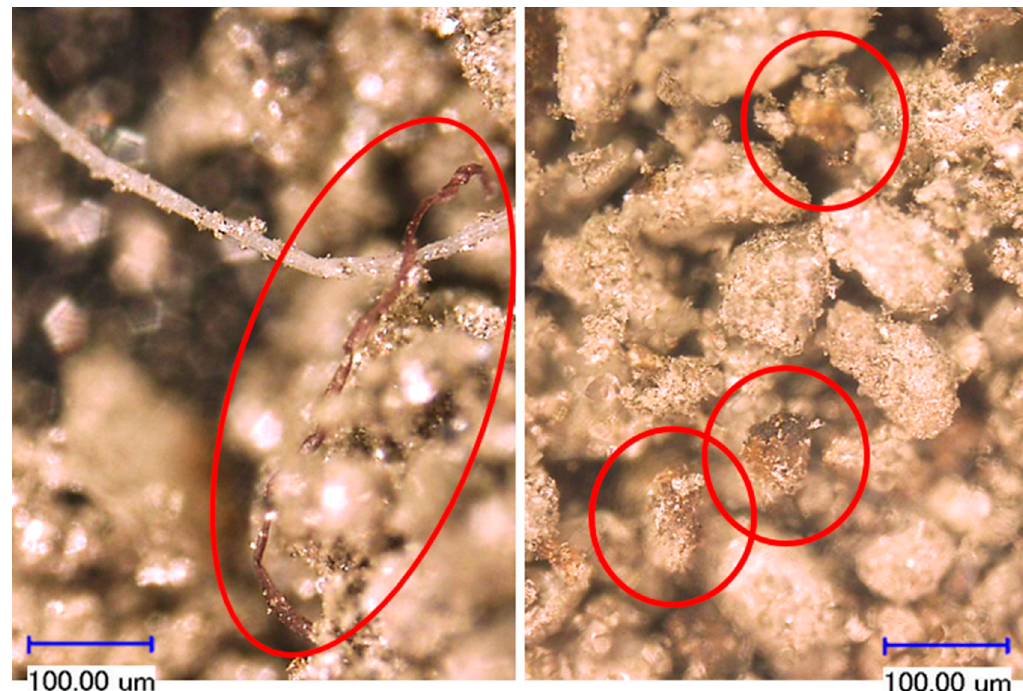
Figure 13. Copper impurities in silver cementate (magnification 500×).